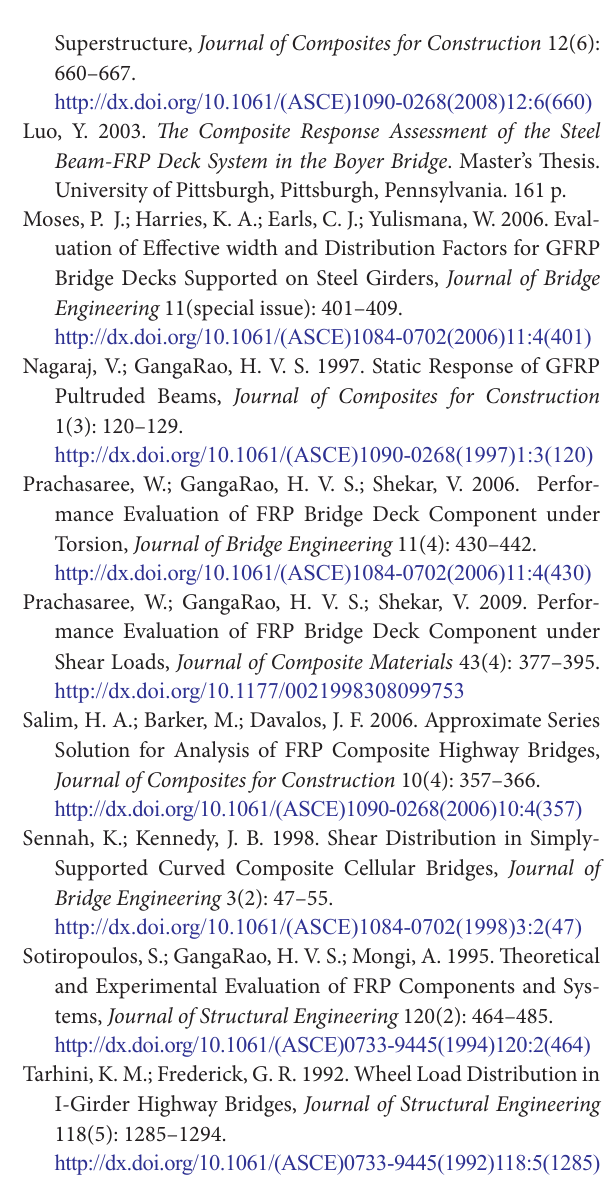
Fig. 7. Comparisons and correlation of load distribution factors with previous